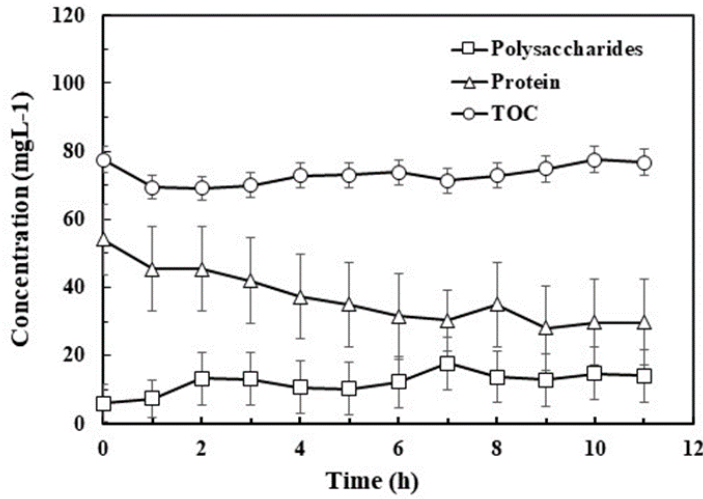
Figure 2. Protein, polysaccharides, and total organic carbon (TOC) concentrations at different intervals in EPS solution during the ozonation process.